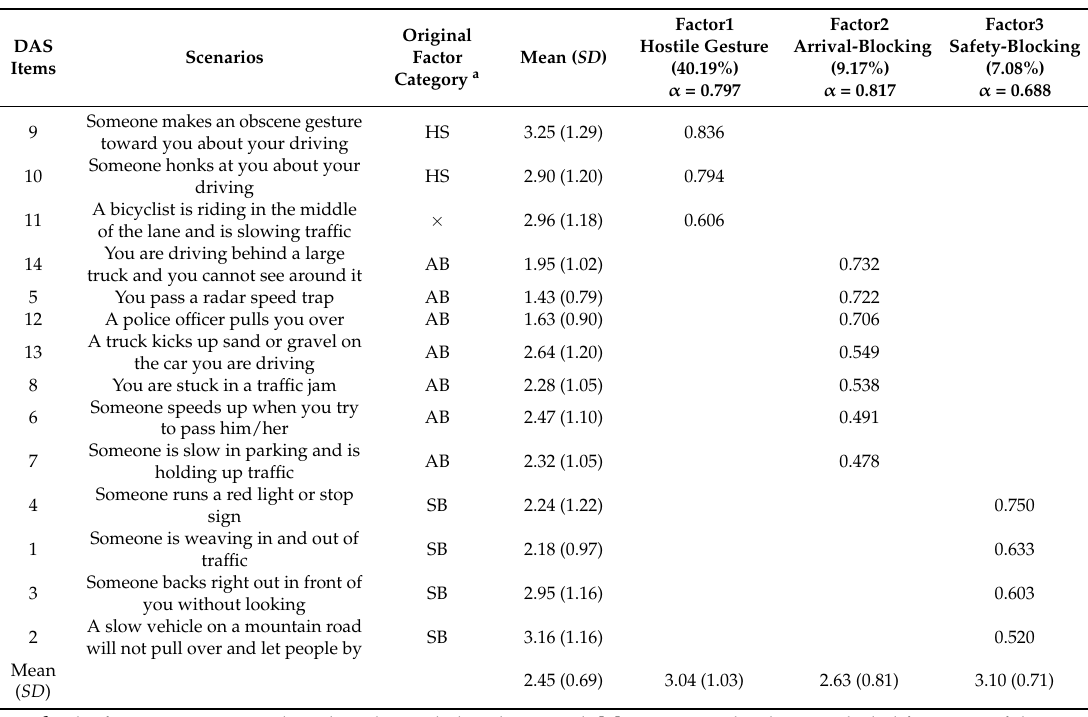
Table 2. Mean and standard deviation (SD) of each DAS item and the results (number of factors determined, factor loading, etc.) of